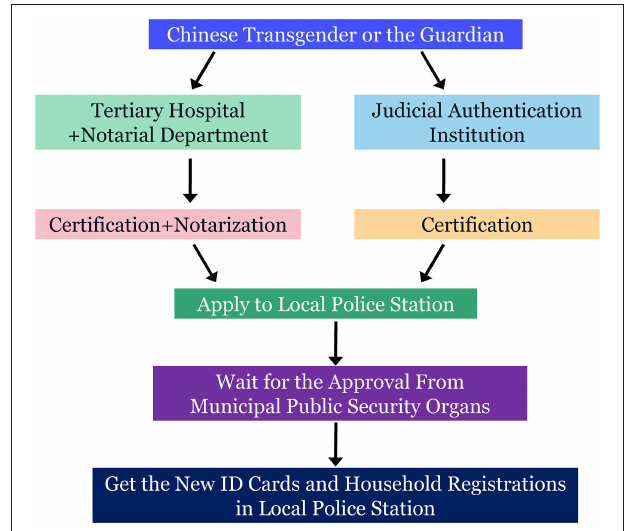
FIGURE 1 | The detailed ID card change process for transpersons in